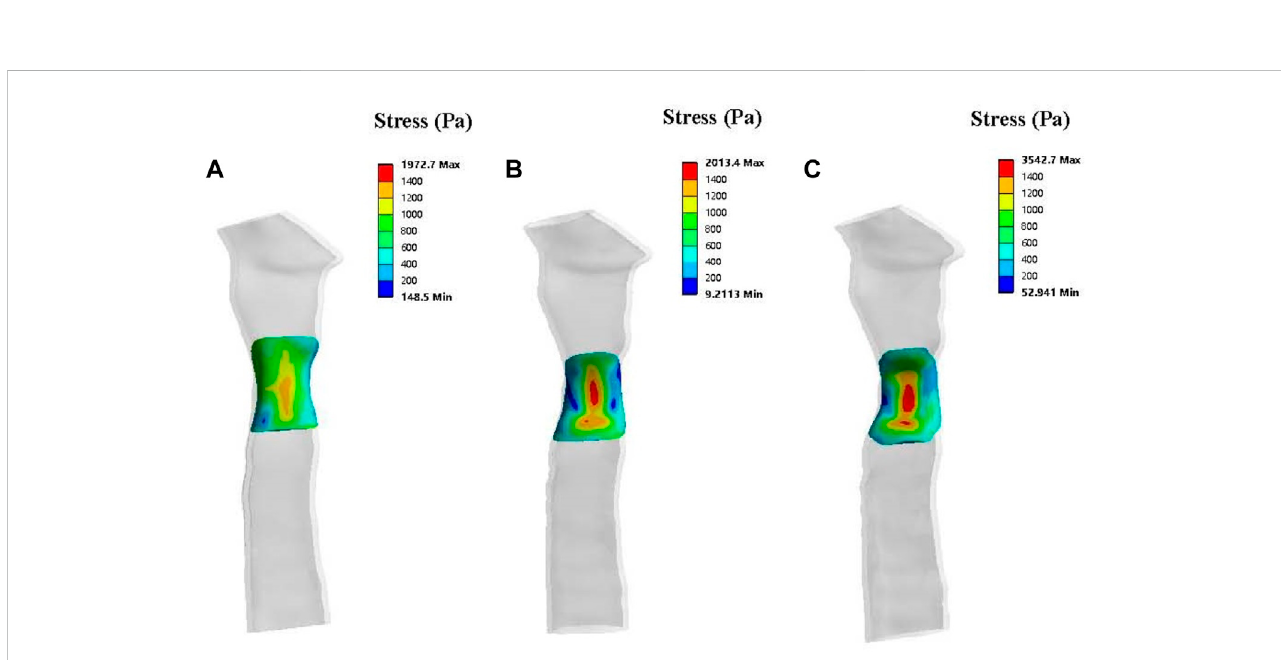
FIGURE 7 Solid simulations depicting the contours of stress distribution on the patch for patient one. The lateral view of a normal trachea (A) , a trachea with 33% stenosis (B) and a trachea with 50% stenosis (C) .